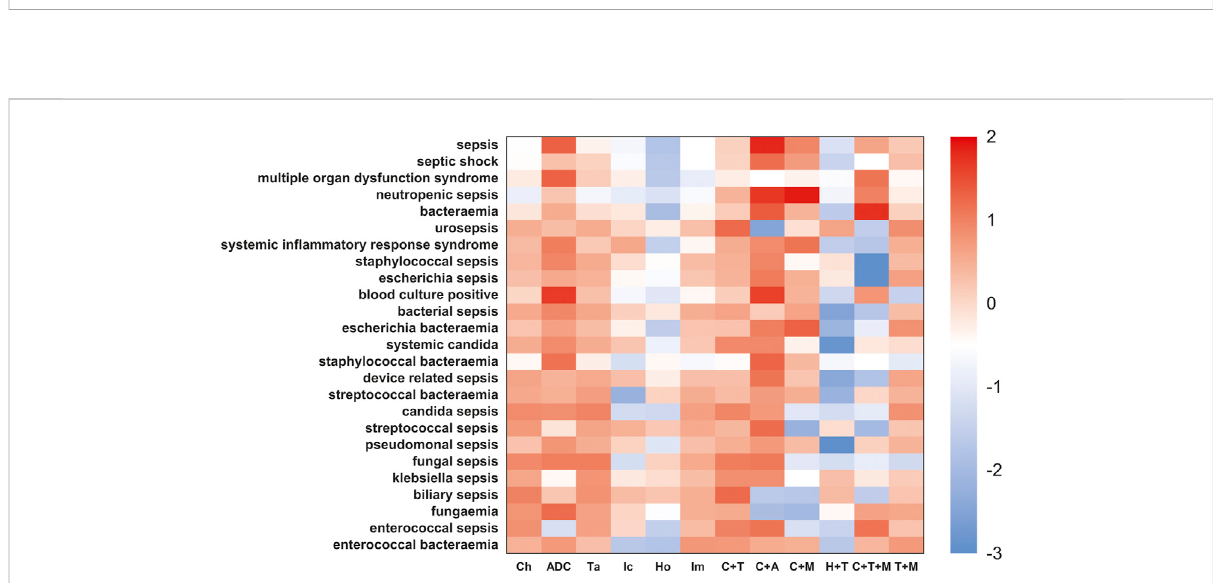
FIGURE 7 Sepsis-related toxicities landscape among ADCs and other anticancer therapies (vs. global control). The heatmap represents a comparative analysis of differential risk pro fi les of sepsis and related AEs across cancer drug regimens, such as Ch-chemotherapy, ADC-antibody – drug conjugates, Ta-targeted therapy, Ic-immunotherapy, HO-endocrine therapy, Im-immunomodulatory drugs, and C+T-chemotherapy combined withtargetedtherapy.TheseregimenswereextractedfromguidelinesofFDA-approvedindicationsforADCs.Forthemoreconservativeglobal controls, we selected cancer patients not on any of the aforementioned cancer regimens, that is, patients not taking Ic, Ta, Ch, Ic+Ta, Ch+Ic, and Ch+Ta.Theredcolorindicatesahighriskofadverseeffectindifferentcancerdrugregimens.ThisanalysisdemonstratedADCshadthehighestsafety concern for sepsis, multiple organ dysfunction syndrome, pseudomonal sepsis, fungemia, and blood culture positive than any other cancer drug regimens ( p <